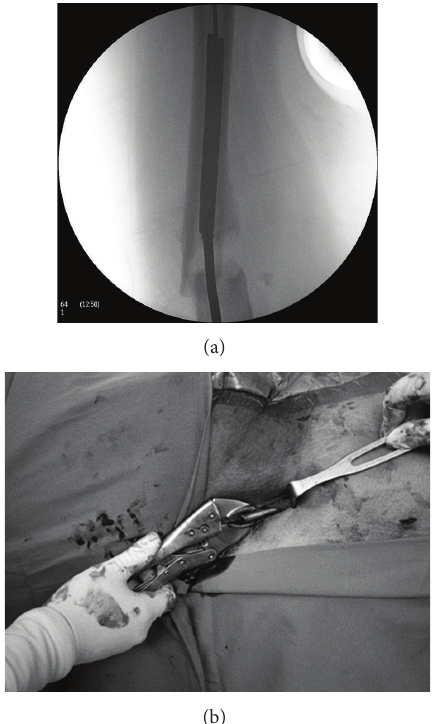
Figure 5: The broken nail is retrogradely impacted and finally removed from the proximal